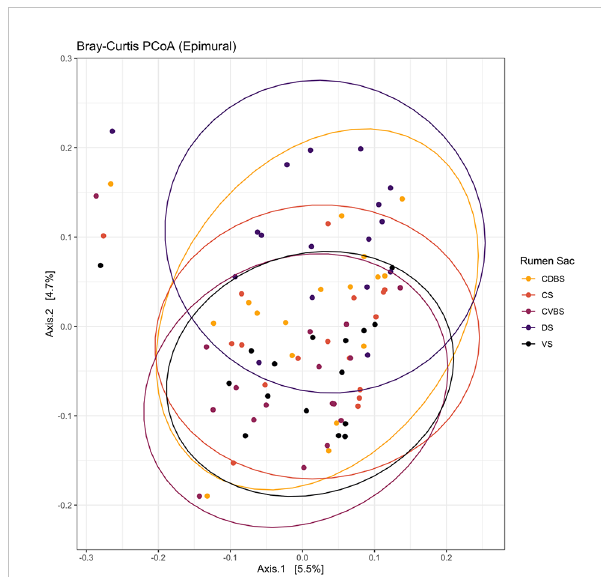
FIGURE 10 Bray-Curtis principal coordinates analysis of the epimural fraction among the fi ve rumen sacs. Beta-diversity was measured with the Bray-Curtis distances and visualized with a principal coordinates analysis (PCoA). The CDBS is shown in the orange circles, CS is shown in red circles, CVBS is shown in light purple circles, DS is shown in dark purple circles, and VS is shown in black circles. The circles represent a 95% con fi dence interval around the means of the epimural communities in each rumen sac. Signi fi cance was determined at P <